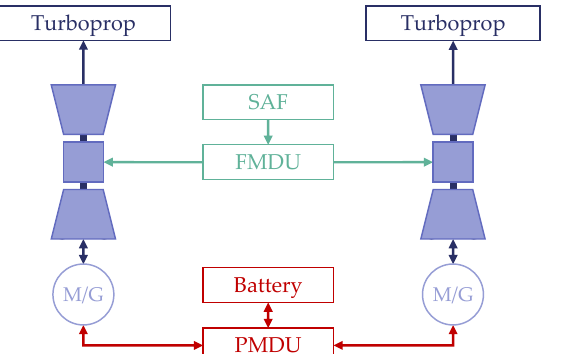
Figure A2. Architecture 1: Parallel hybrid-electric architecture with electric motors boosting the gas turbines.